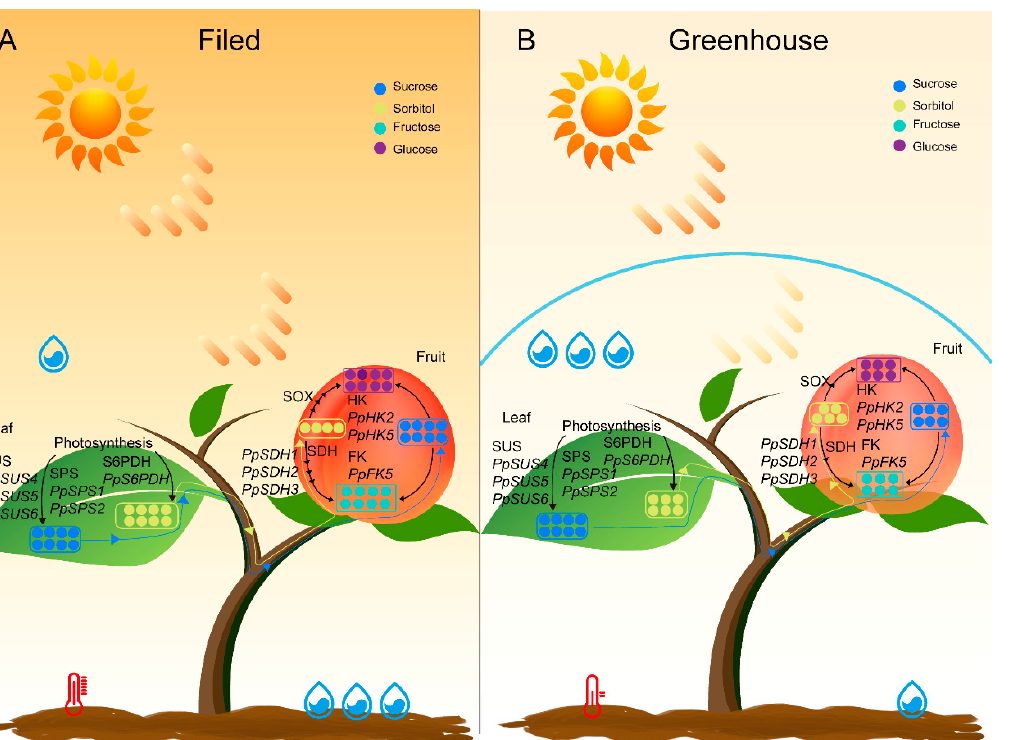
Figure S2: SOX activity in different parts of peach grown in the field and greenhouse. (A–C) show the SOX activities in leaves, fruits and phloem, respectively. The data are presented as the means ± SDs from three biological replicates. Different lowercase letters indicate significant differences ( p < 0.05); Table S1: Primers used for